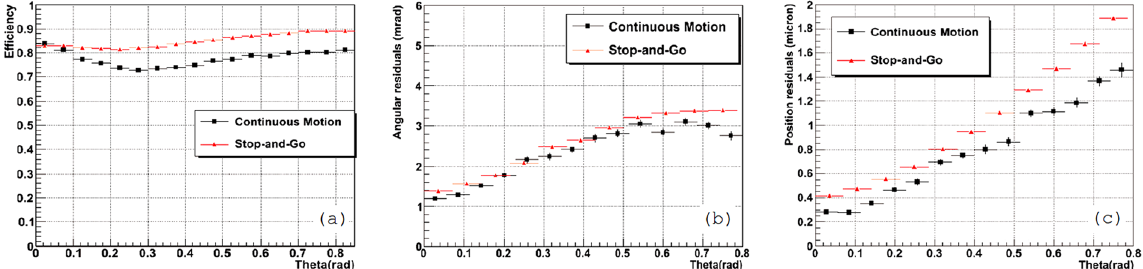
Figure 8. Base track reconstruction efficiency ( a ), angular residuals ( b ) and position residuals ( c ) versus track angle measured with a NGSS